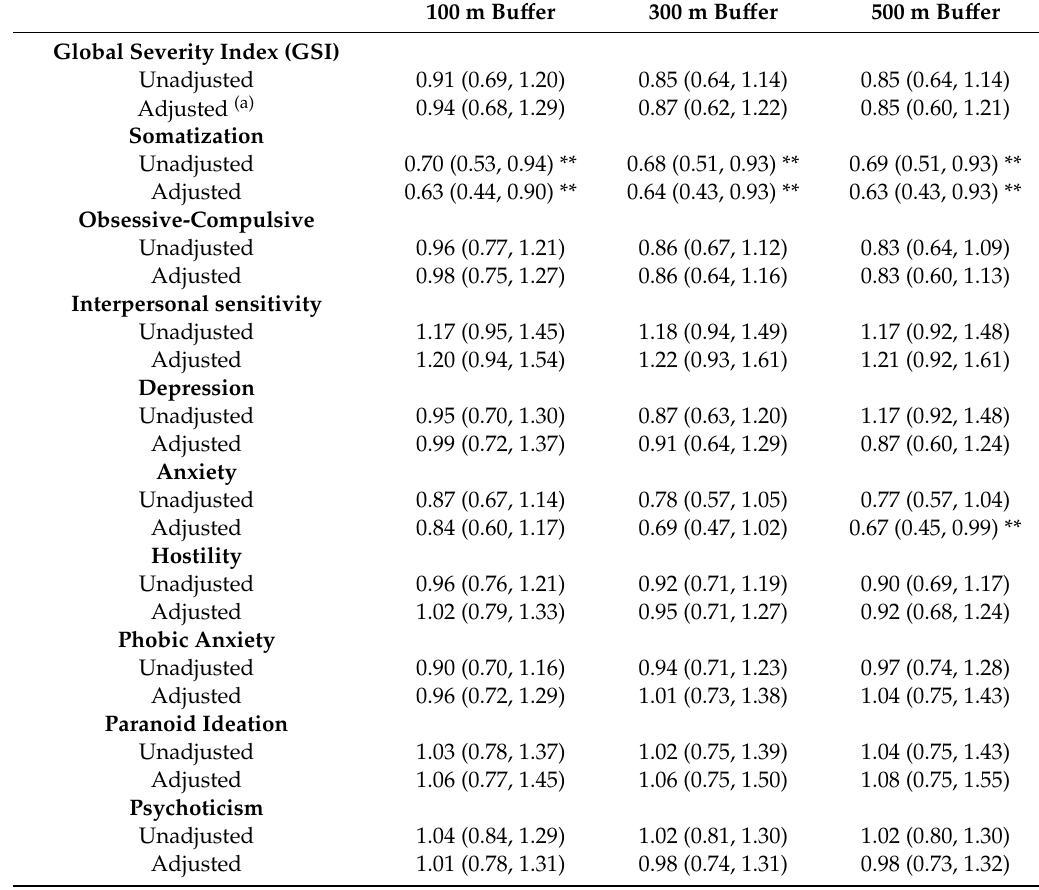
Table 3. Adjusted and unadjusted logistic regression models for each bu ff er of the average of residential surrounding greenspace at delivery and at 4-year follow-up, and risk of each symptomatic dimension of the SCL-90-R. Odds Ratio (OR) and 95% confidence intervals (95% CI) for 1-IQR increase in each continuous indicator of residential surrounding